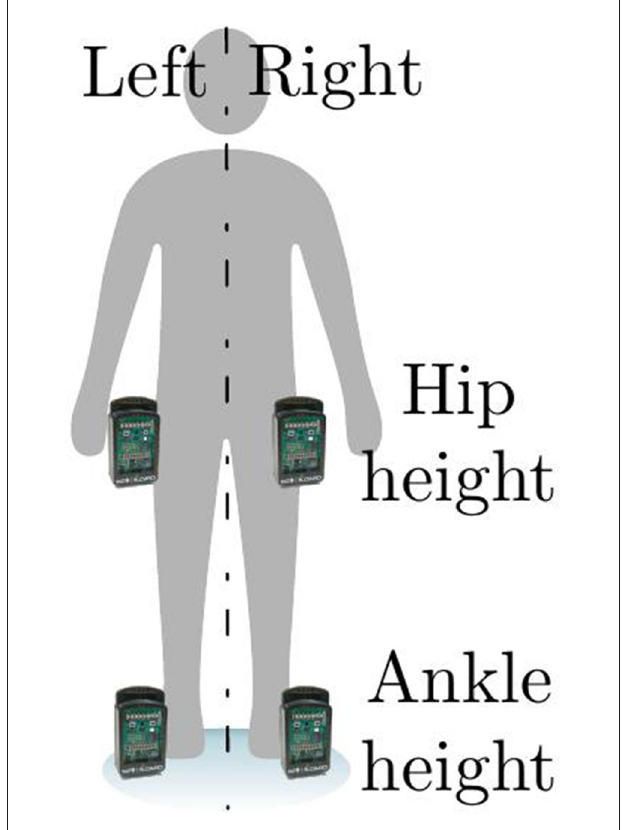
FIGURE 1 | Localization of the measurement devices and spatial axes